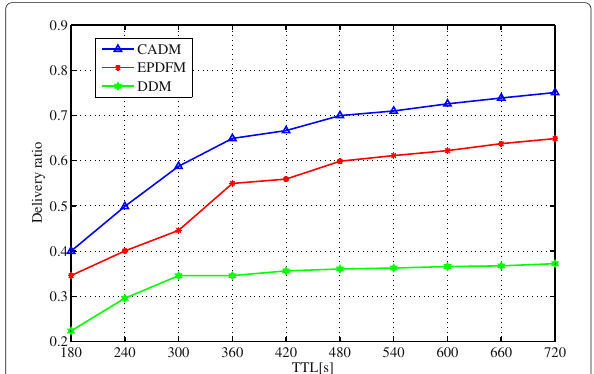
Fig. 5 The average delivery delay under various numbers of users Fig. 6 The successful delivery ratio under various TTL of